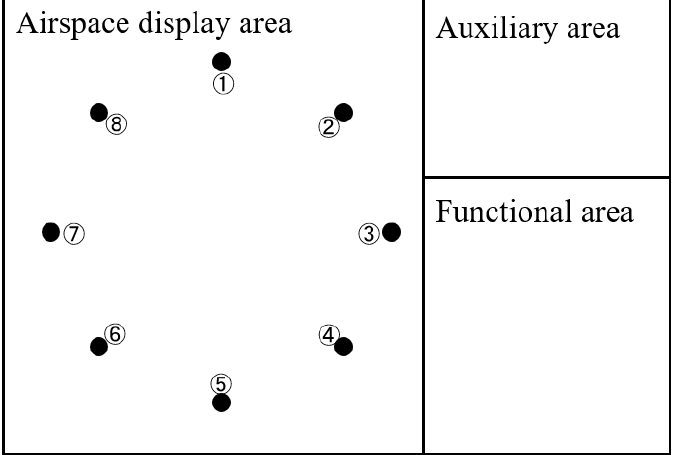
Figure 1. The layout of the simulation software’s interface. Aircraft are generated and displayed on the left area, with specific information of each aircraft listed on the lower right area. The upper right area serves for displaying the time and